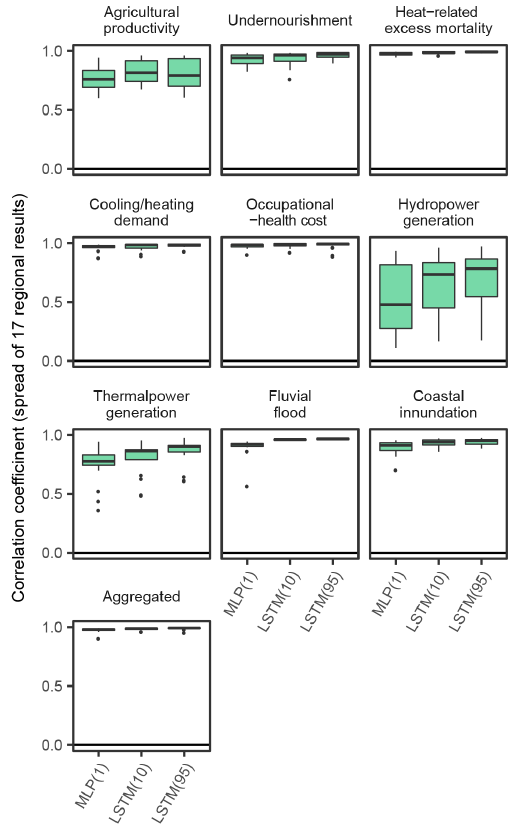
Figure 6. Relationship between number of input variables and per- formance of emulators. Medians of 17 regional results are plotted as points. Fitted curves are produced for the frontiers (Pareto opti- mal corresponding to each number of input variables) by beta re- gression. When time-series input data are used, the number of input variables is multiplied by the length of the time